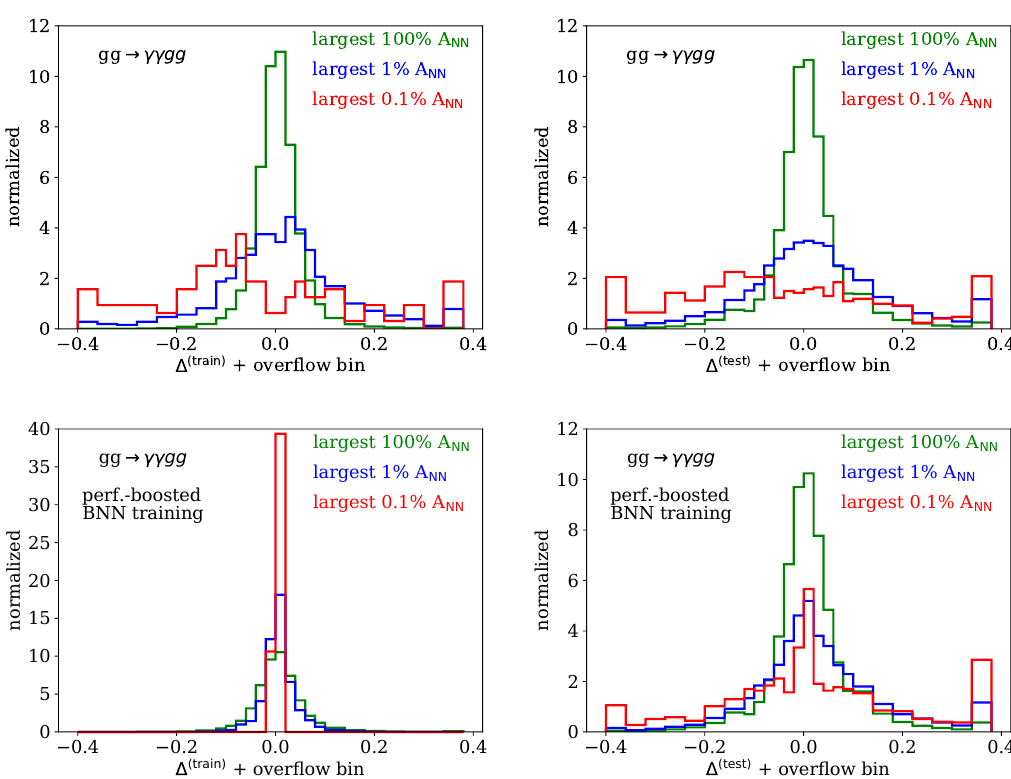
Figure 12: Performance of the basic (upper) and performance-boosted (lower) BNNs for the ( 2 → 4 ) -process in terms of the precision of the generated amplitudes, Eq.(3), evaluated on the training (left) and test datasets (right). on the training data in the poorly learned kinematic tails. After integrating over the additional phase space directions this improvement translates well into the test dataset, but at the expense of the uncertainty estimate on the training